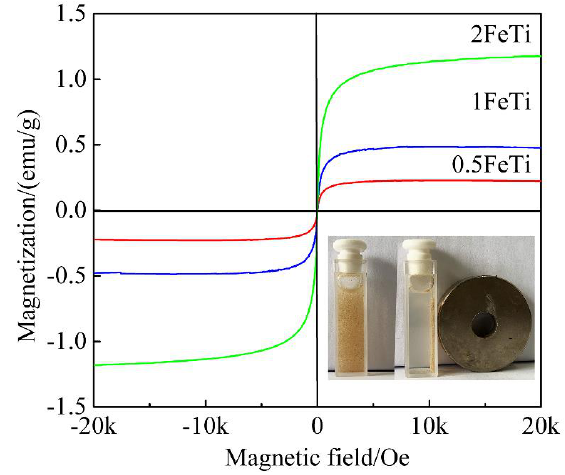
Figure 7. Magnetization curves of 0.5FeTi, 1FeTi and 2FeTi. (The inset is the magnetic separation process of 1FeTi in solution using a magnet).